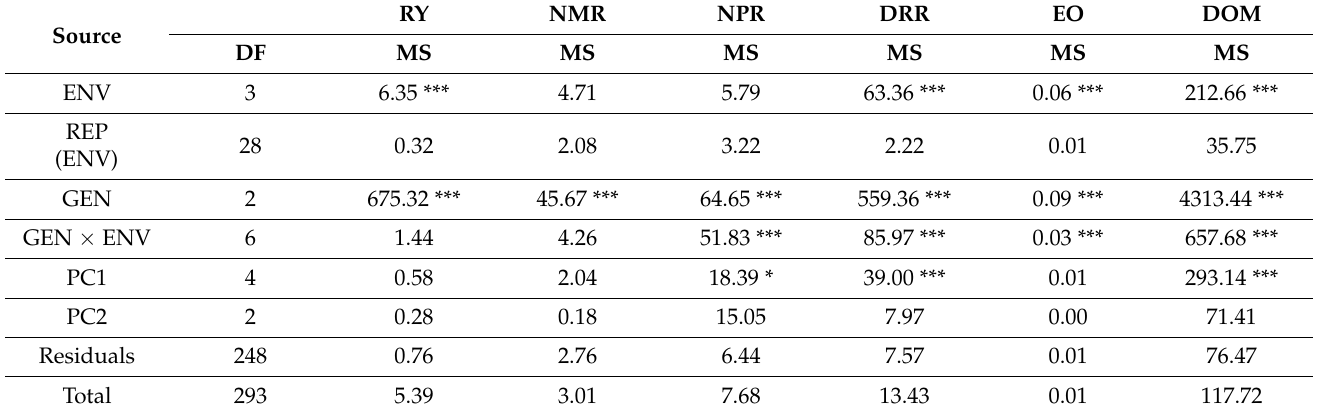
Table 6. AMMI analysis of variance of the six traits for three selected genotypes in MLT.